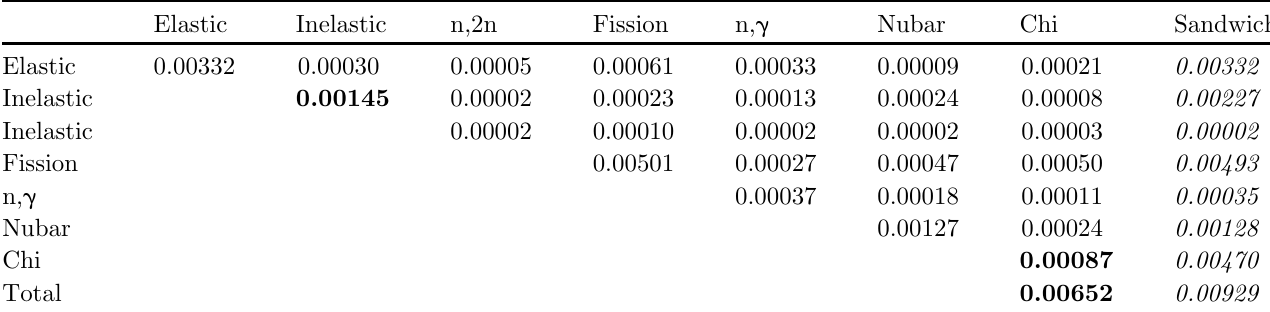
Table 4. Backwards HMM (SANDY) uncertainty propagation